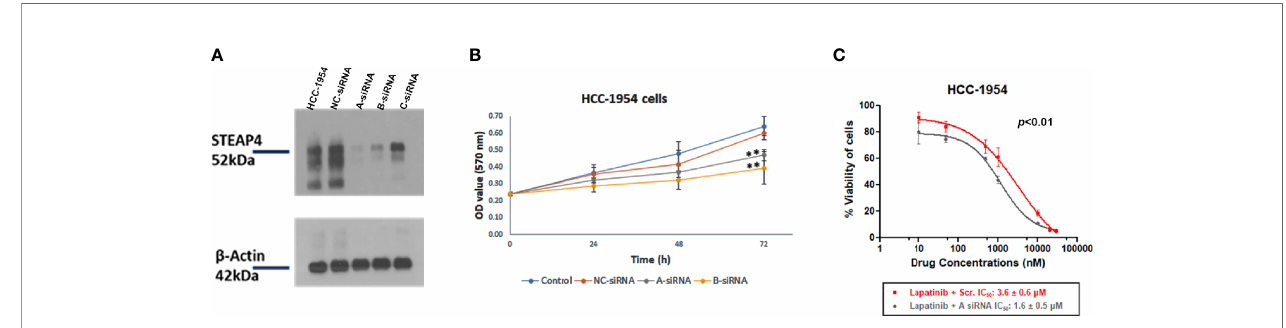
FIGURE 6 | Effect of STEAP4 silencing on cell proliferation and Lapatinib inhibition in HCC-1954 (HER2+) cells. (A) Knockdown ef fi ciency of the three siRNA duplexes on STEAP4 protein expression in HCC-1954 cells, as assessed by Western blot analysis 48 h after transfection with 10nM siRNAs. (B) HCC-1954 cell growth curves at 24, 48, and 72 h after transfection with 10nM siRNAs. Cell proliferation OD values were detected by MTT assay. STEAP4 A-siRNA and B-siRNA signi fi cantly reduced cell proliferation at 72 h of transfection as compared to the NC-siRNA (non-silencing of STEAP4) or Control group (** p < 0.01). (C) Dose – response curves and the IC50 values after siRNA and Lapatinib treatment. HCC-1954 cells were treated with a fi xed concentration of siRNAs (10 nM) and different concentrations of Lapatinib for 72 h to assess the effect of A-siRNA and Lapatinib on cell viability using the MTT assay. NC-siRNA (non-silencing of STEAP4) was used as the negative control for comparison ( p < 0.01). The results represent the mean values ± SD of three independent